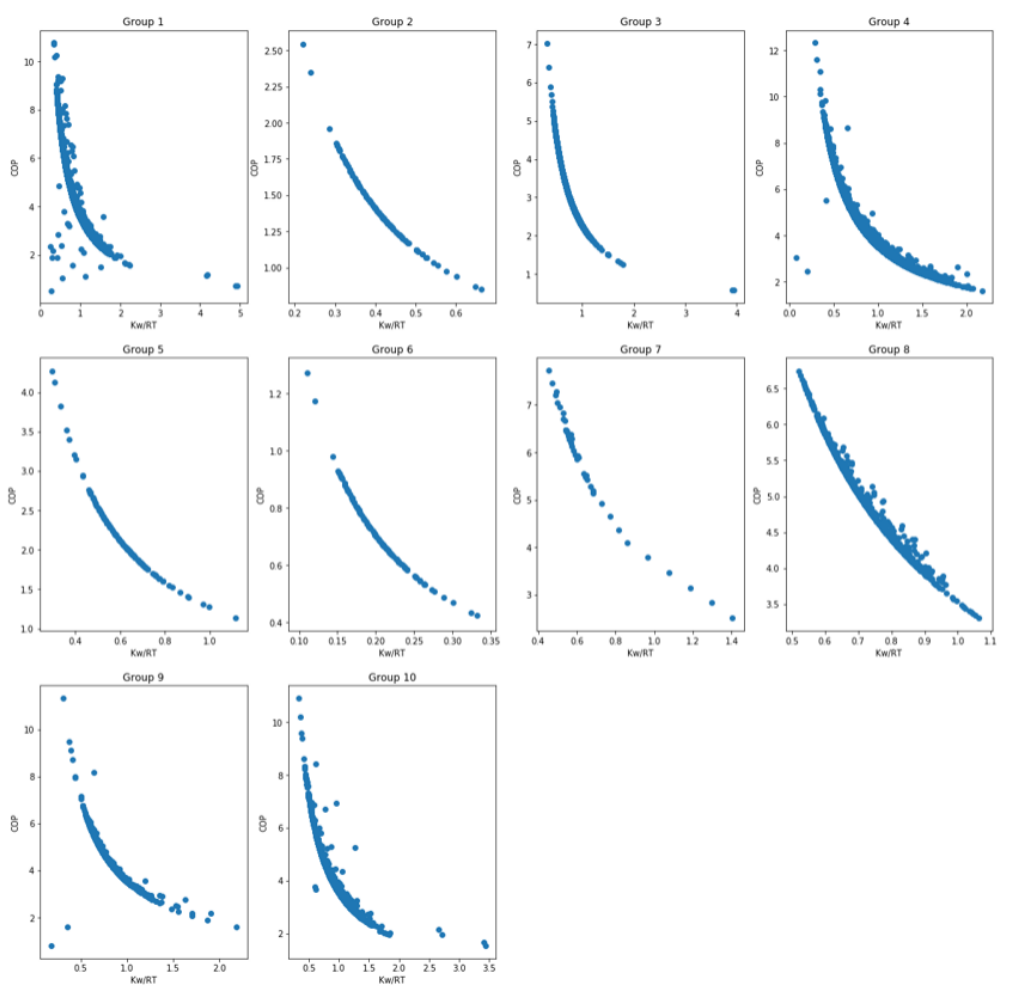
Figure 8. Scatter diagram of the kW/RT and COP after clustering.